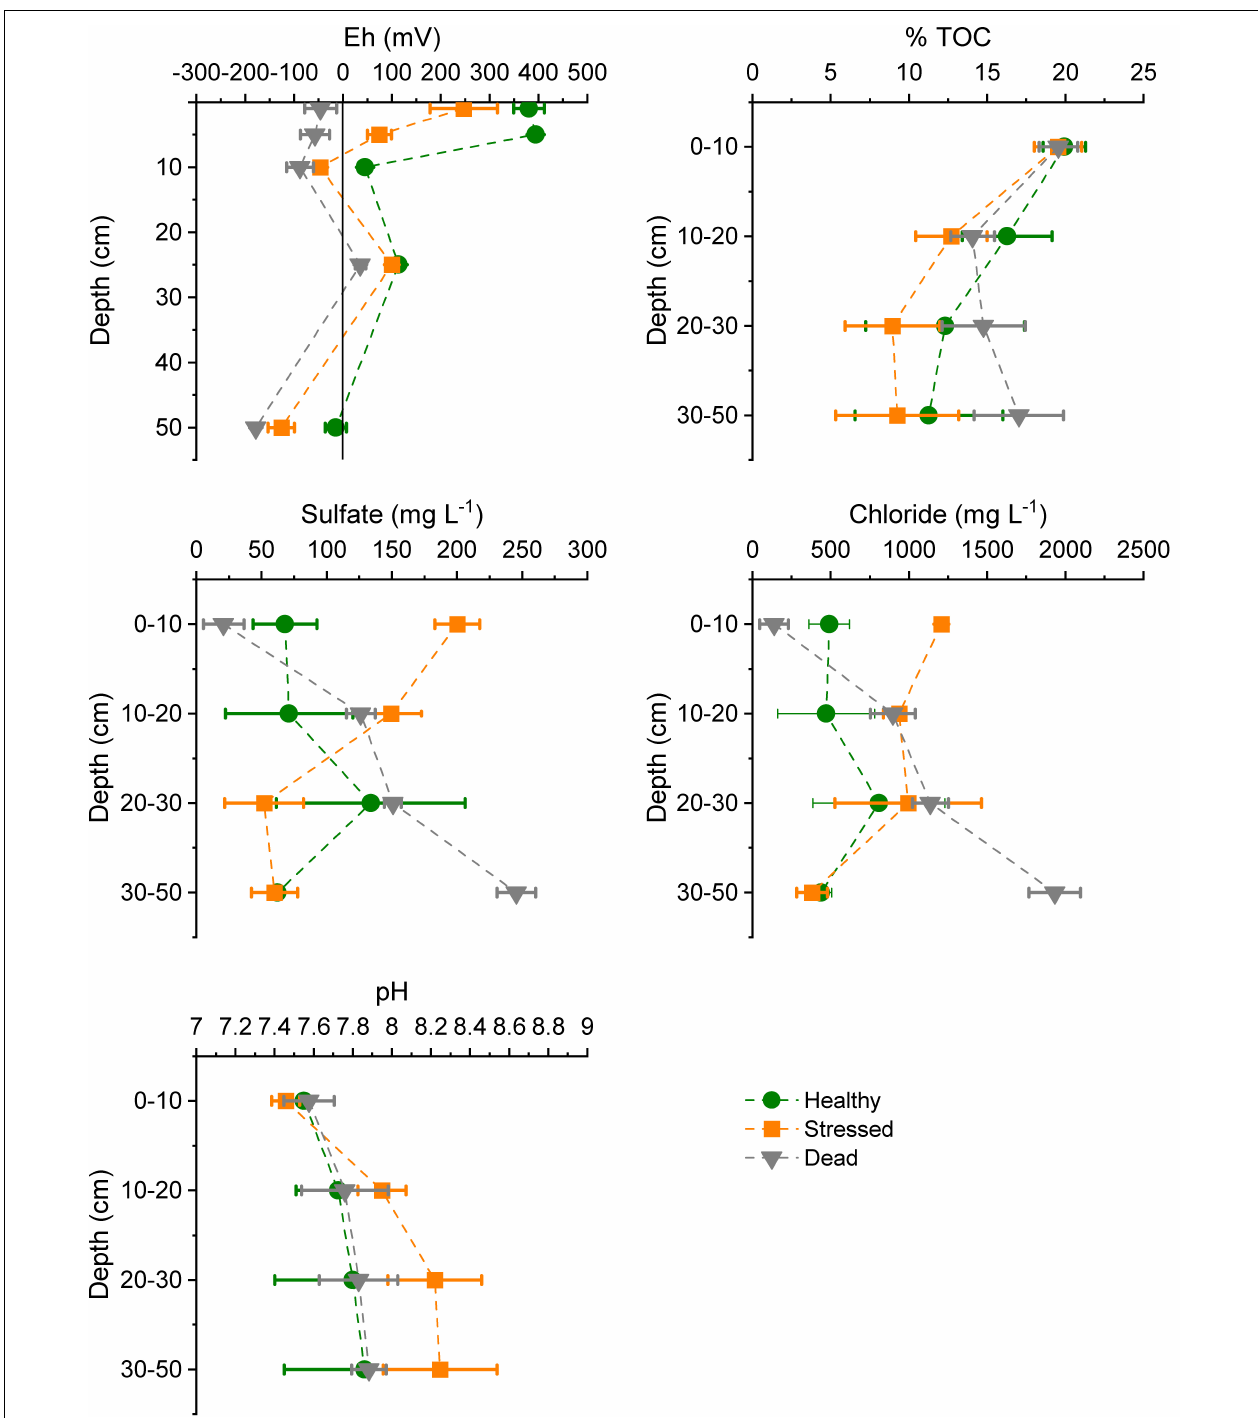
FIGURE 4 | Soil characteristics at the three mangrove zones at St Kilda, South Australia, measured in mid-2021, showing mean ± standard error based on samples from two to three plots per zone. TOC, total organic carbon.